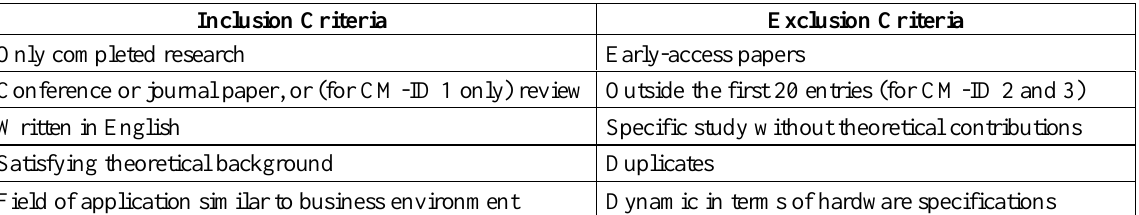
Table 1. Inclusion and exclusion